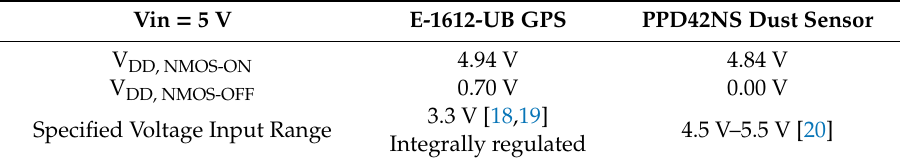
Table 2. Selected voltage characteristics of GPS and dust sensors [16].